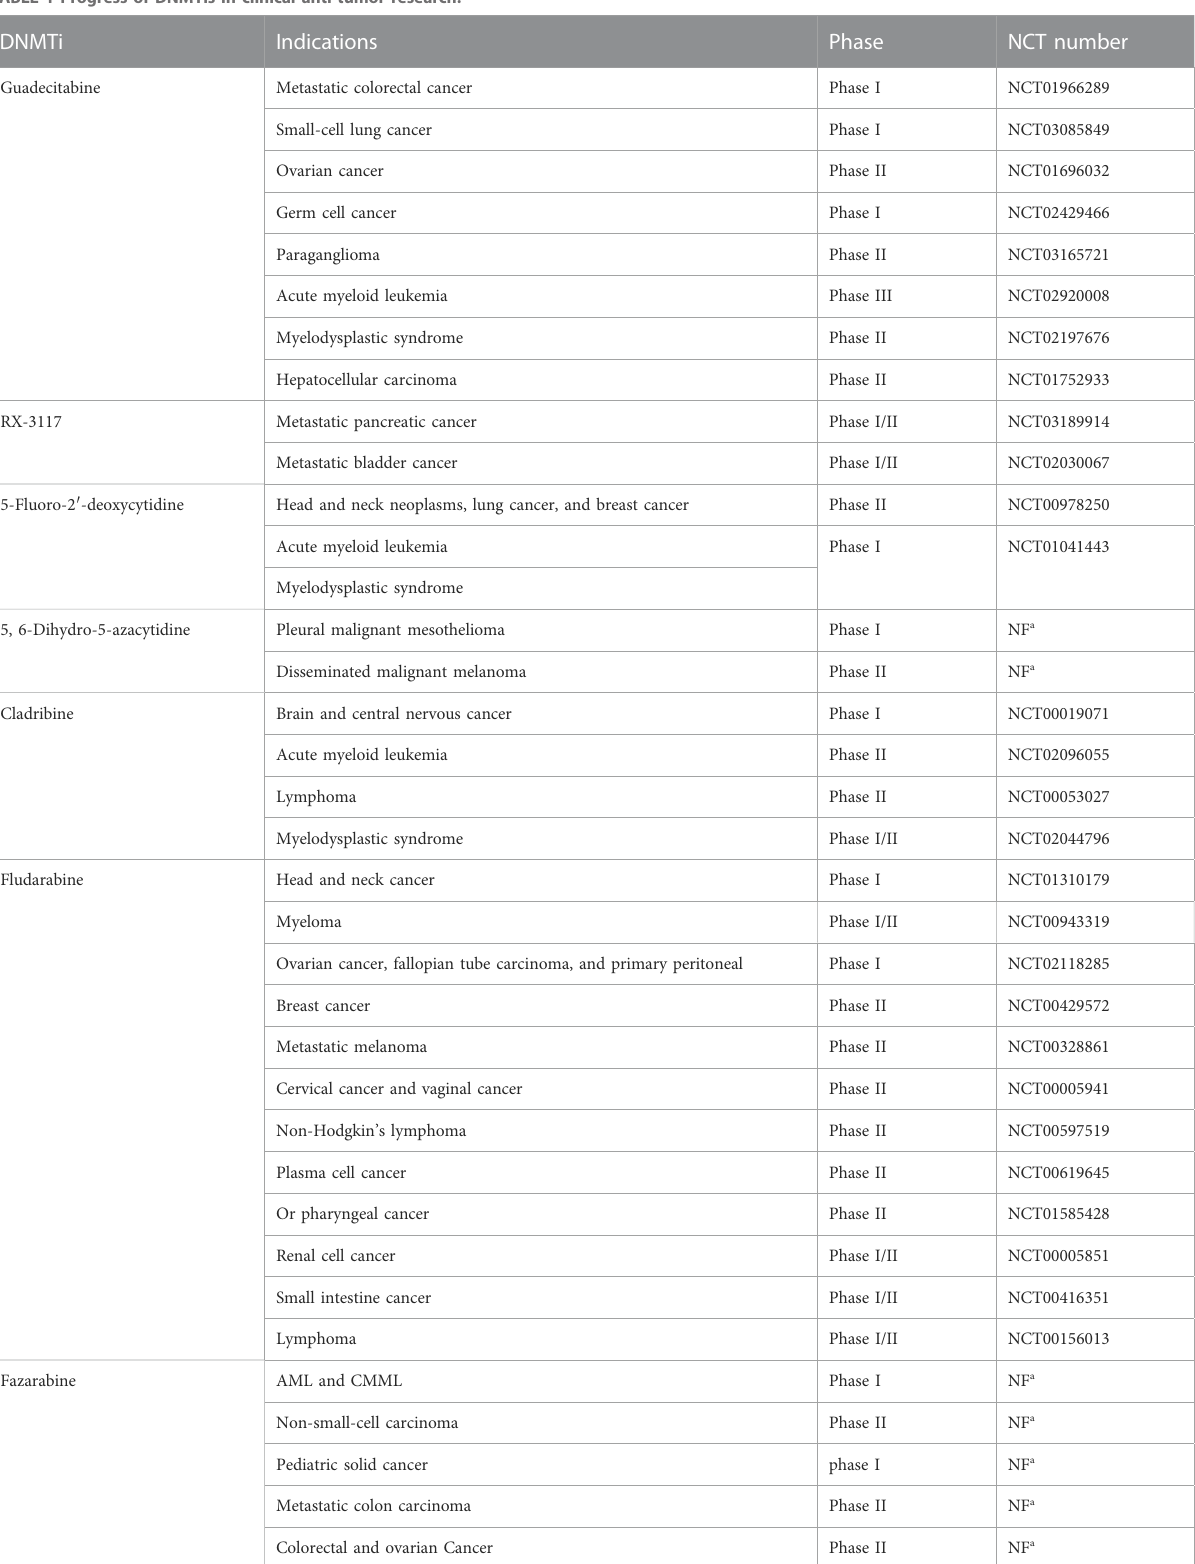
TABLE 1 Progress of DNMTis in clinical anti-tumor